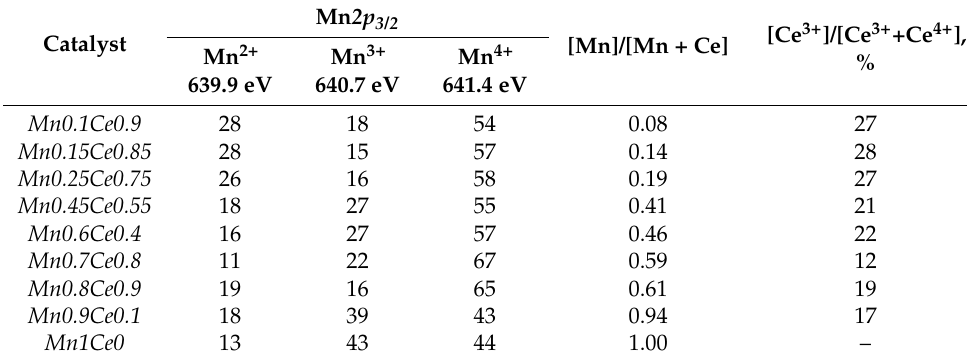
Table 2. Relative atomic concentrations of Mn and Ce cations in the near-surface layer of the studied